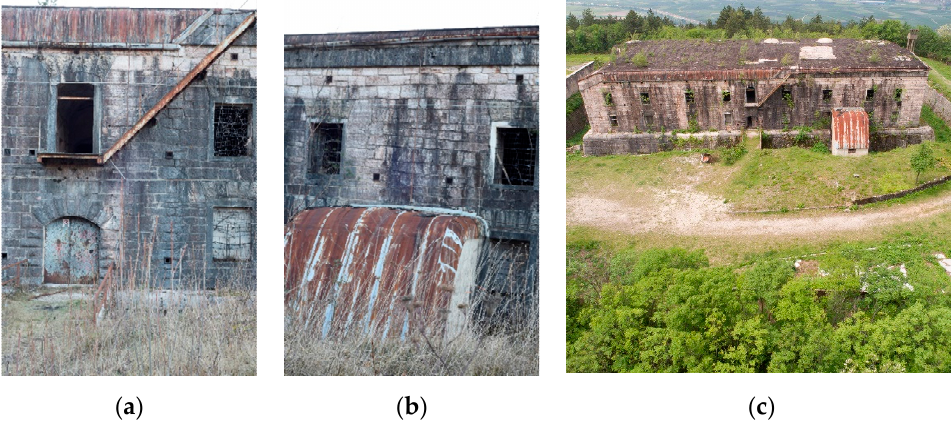
Figure 12. Some images of the WWI Fortification dataset: terrestrial ( a , b ) and UAV images ( c ). From the joint processing of UAV and terrestrial images, some 1.2 mil. 3D tie points were computed and their quality parameters extracted, as shown in Table 12. Table 12. Median, mean and standard deviation values for the quality features values computed on the original (not filtered) sparse point cloud (~1.2 mil. 3D tie points).